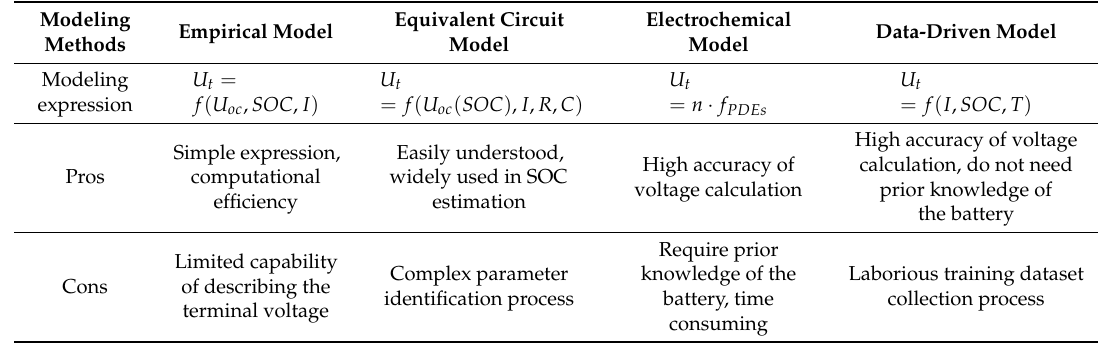
Figure 4. The classifications of battery modeling methods. Table 4. Pros and cons of the modeling methods.